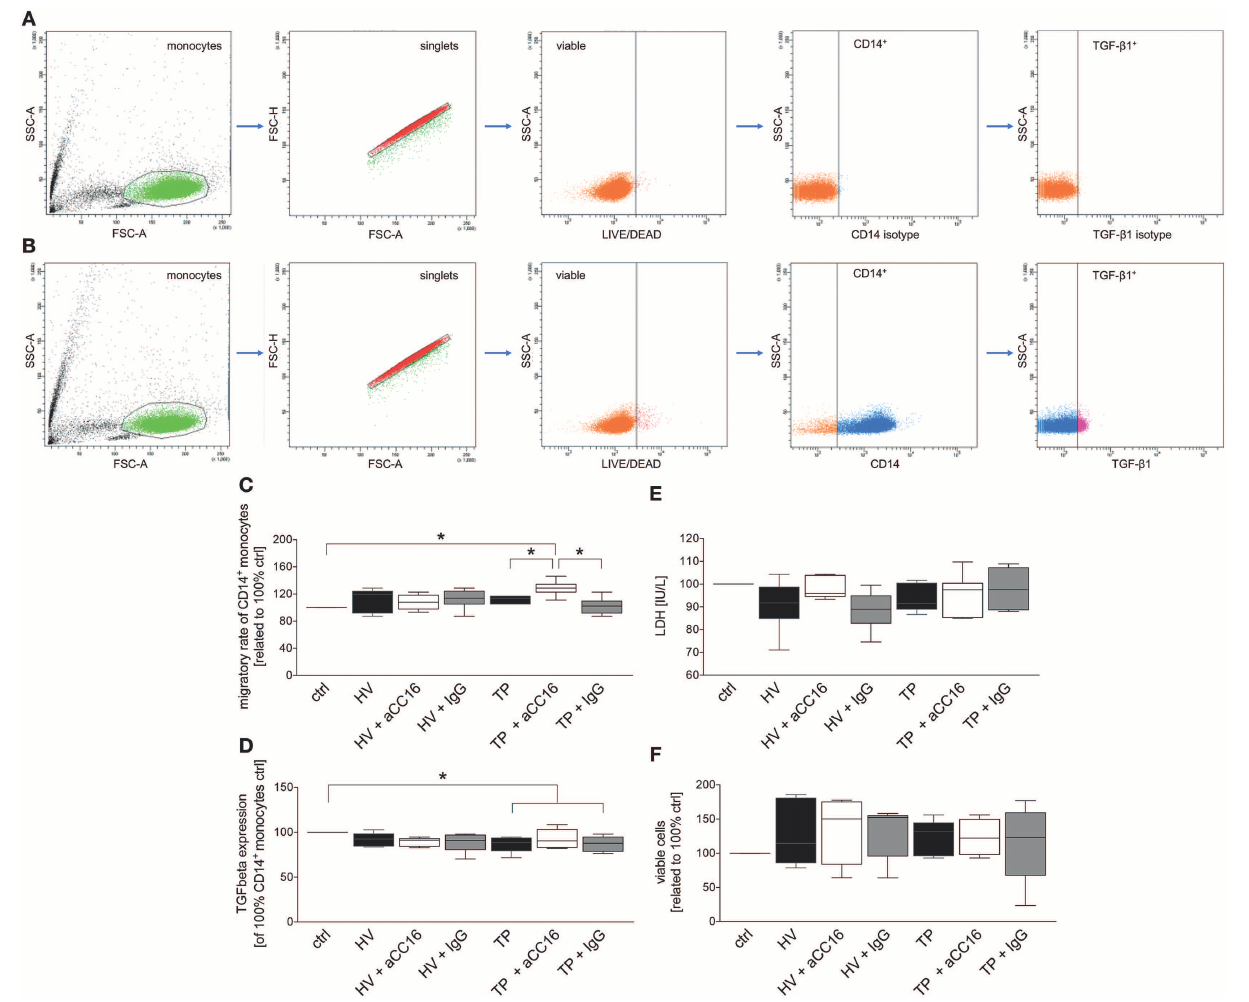
FIGURE 5 | Representative gating strategy for the flow cytometric analysis and evaluation of isolated CD14 + monocytes with regard to their TGF- β 1 expression as dot plot analysis is shown. (A) is showing representative isotype staining controls, while (B) shows representative gating after staining with specific antibodies. (C–F) show effects of serum samples obtained from healthy volunteers (HV) or trauma patients (TP) and CC16 on CD14 + monocytes behavior. CD14 + monocytes isolated from HV were incubated with sera obtained from HV or TP. Cell culture medium was applied alone (control) or with/without prior intervention/neutralization with either CC16 antibody (aCC16) or IgG control antibody (IgG) in sera from HV or TP. Migratory capacity toward MCP-1 (C) , TGF- β 1 expression (D) , and the impact of sera on monocyte cytotoxicity (E) and viability (F) were evaluated. Data are represented as box-whisker plot and min to max, * p < 0.05 vs.